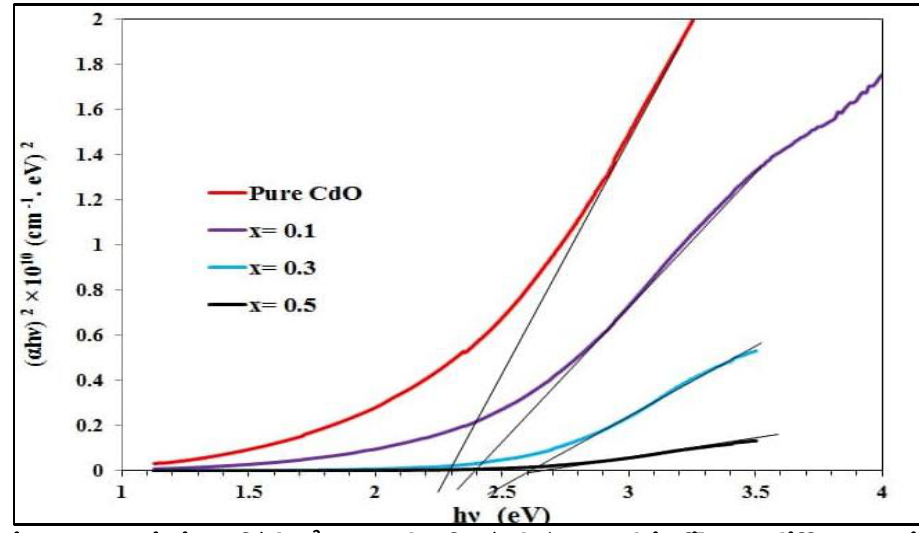
Figure 5: Variation of (αhυ) 2 versus hυ for (CdO)